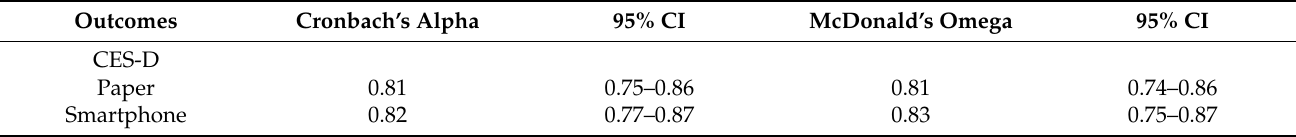
Table 4. Internal consistency for CES-D, GAD-7, and